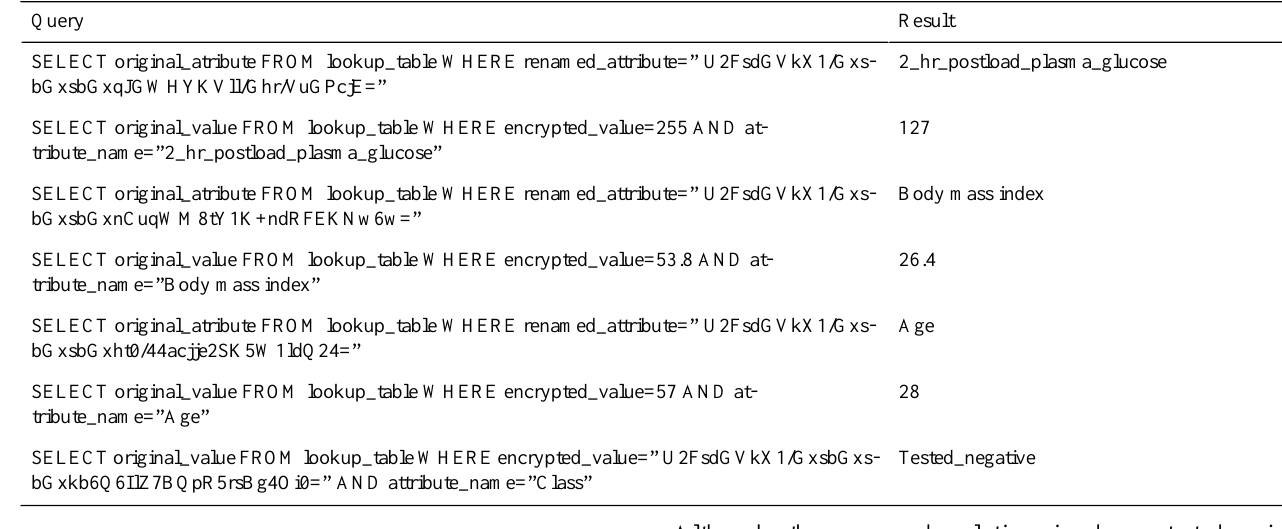
Table 4. List of queries for transforming encrypted data to original.